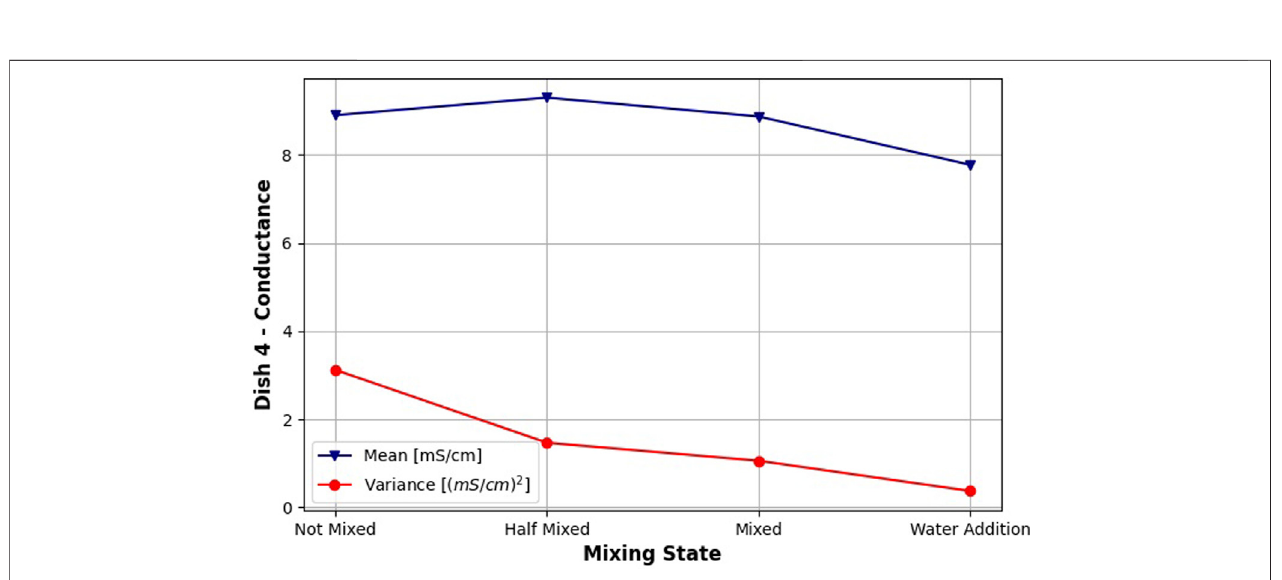
FIGURE13| Effectofaddingwatertoadishvarietywithnotomato.Meanandvarianceofsalinitymeasurementsforthreedifferentstagesofchewingandadditional mixing after adding 50 ml of tap water.